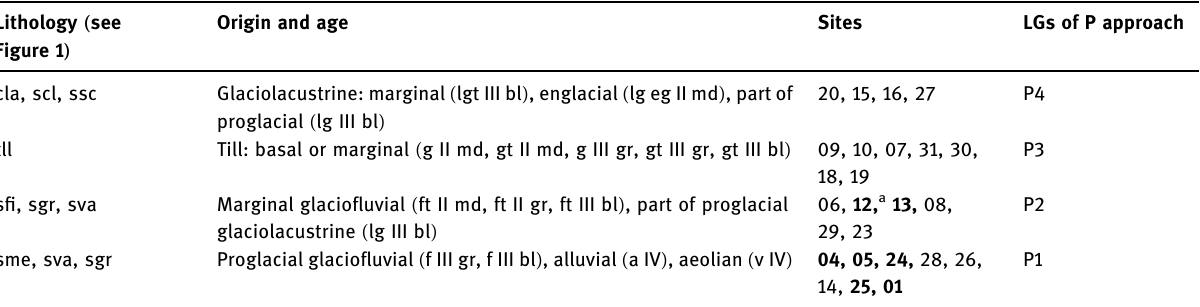
Table 3: Proposed LGs using P approach based on the underlying Quaternary deposits in sites Lithology ( see Figure 1